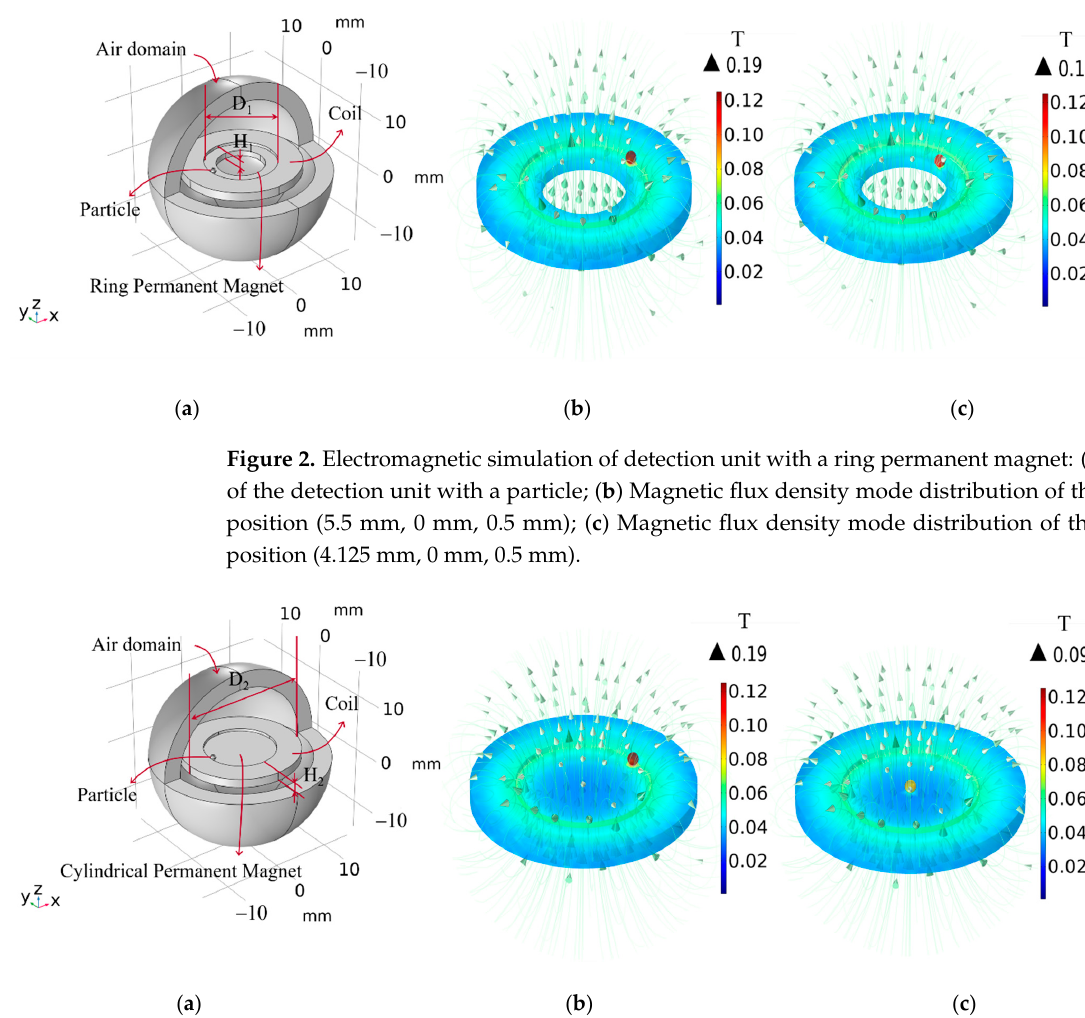
Figure 3. Electromagnetic simulation of detection unit with a cylindrical permanent magnet: ( a ) 3D model of the detection unit with a particle; ( b ) Magnetic flux density mode distribution of the particle at position (5.5 mm, 0 mm, 0.5 mm); ( c ) Magnetic flux density mode distribution of the particle at position (0 mm, 0 mm, 0.5 mm).